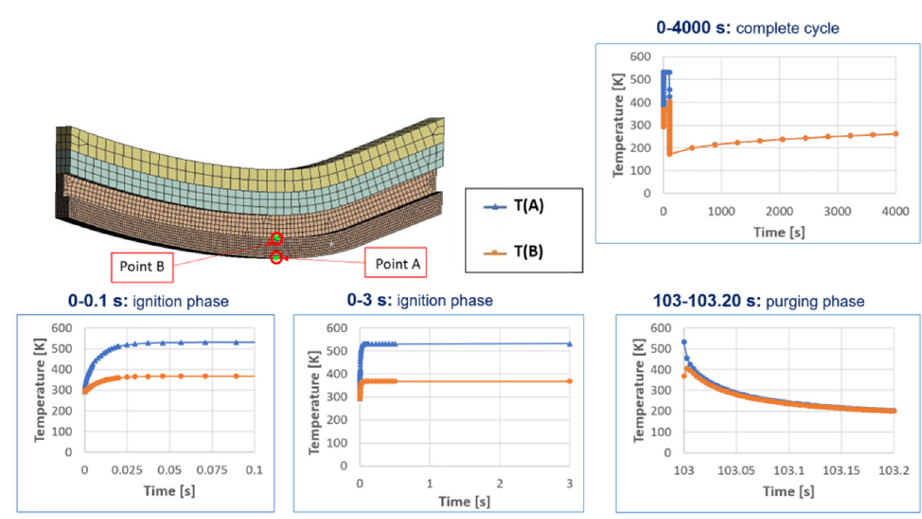
Figure 10. Temperature evolution during the thermomechanical cycle for point A and point B.